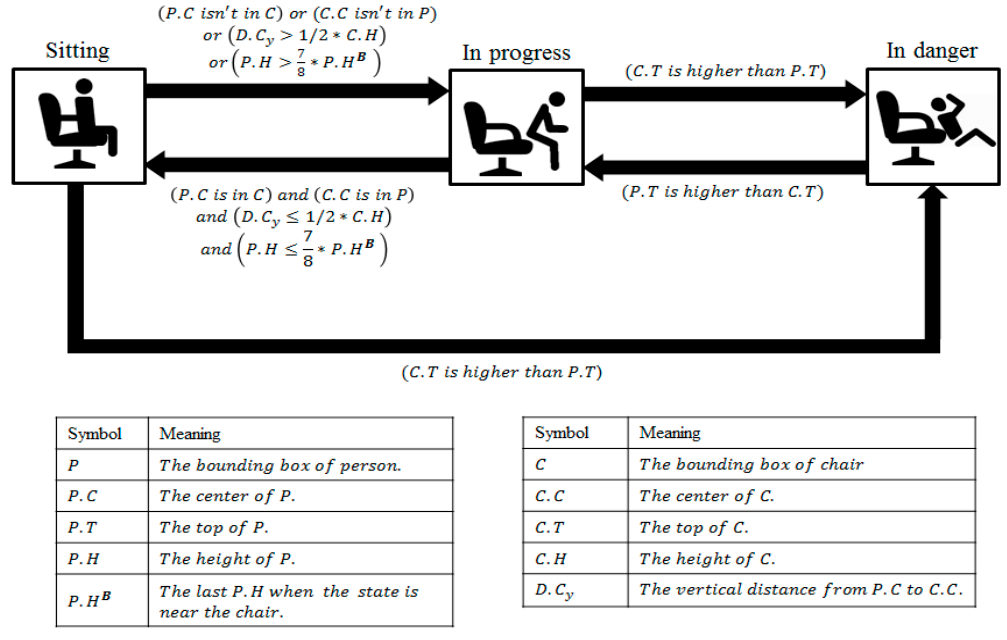
Figure 4. The flow of the state when the person is sitting, in progress, or in danger.